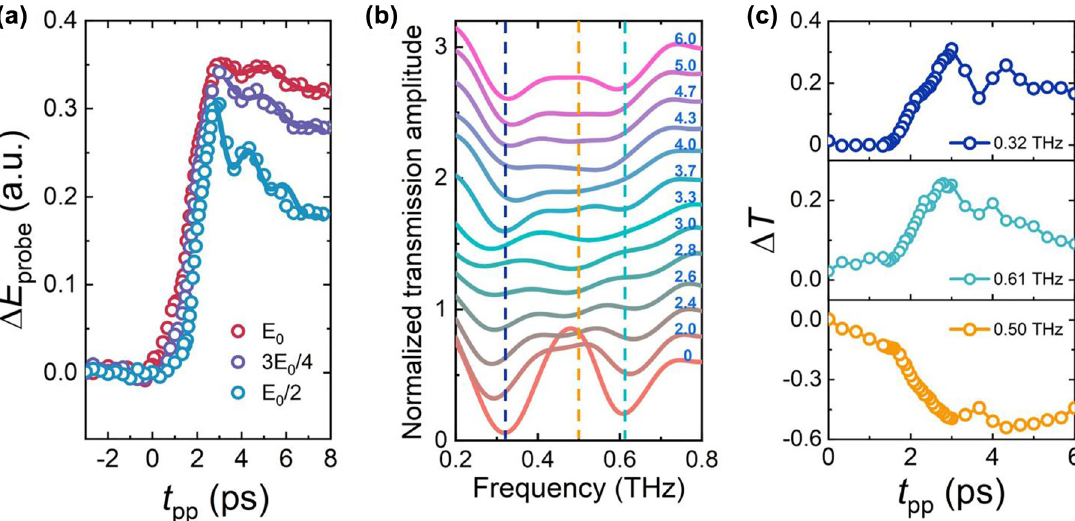
probe when the pp